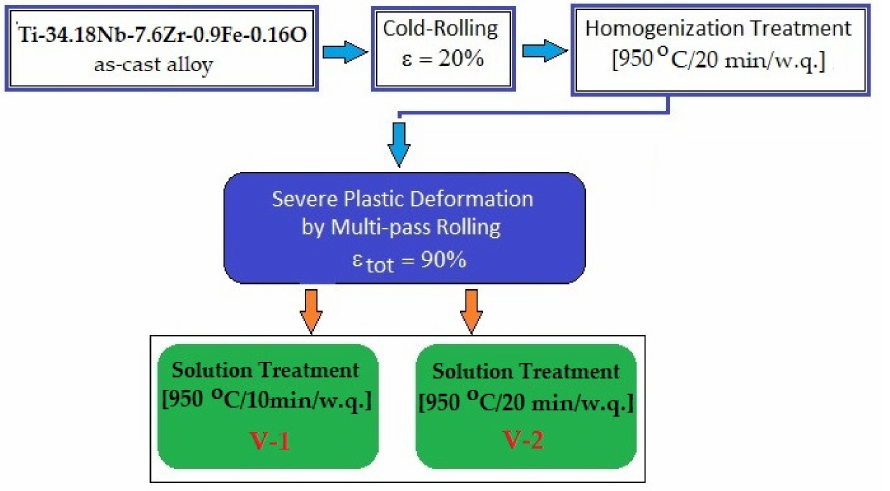
Figure 1. Integral schema for processing the studied Ti–Nb–Zr–Fe–O